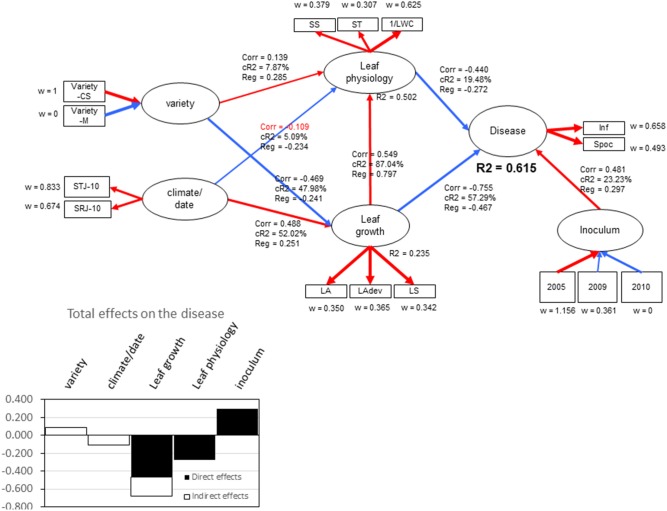
Output of partial least squares path modeling for the two years of experiments describing the relationships between the endogenous latent variable “disease” to the other latent exogenous variables “Leaf growth,” “Leaf Physiology,” “Inoculum,” “Variety,” and “Climate/date.” Corr indicates the correlation coefficient between two latent variables, CR2 indicates the relative contribution of exogenous latent variables to endogenous one, Reg indicates the regression coefficient, R2 indicates the regression coefficient between two latent variables, and w indicates the outer weights yielding the covariances between the manifest variable and its inner latent variable. Blue lines indicate negative correlations, and red lines indicate positive correlations.